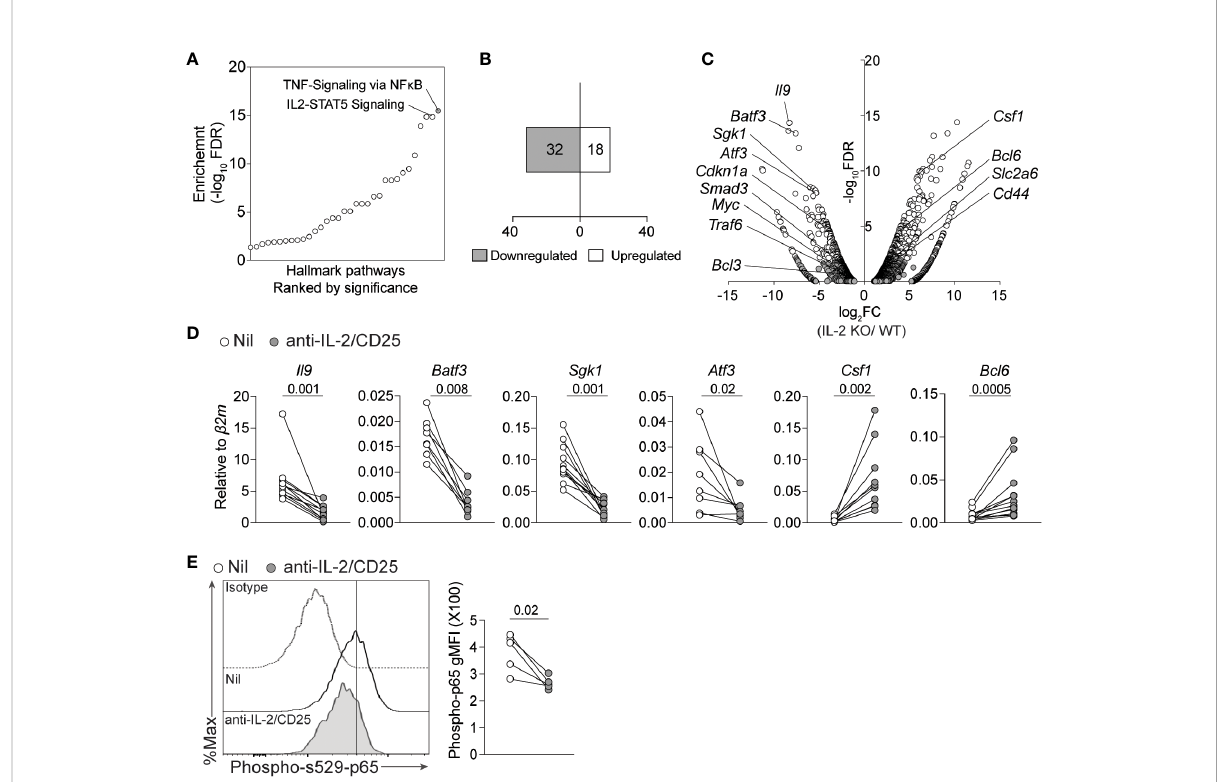
FIGURE 1 IL-2 de fi ciency results in a reduced NF-kB-associated gene signature in Th9 cells. (A) Pathway analysis from bulk-RNA-seq analysis of Th9 cells polarized from WT or IL-2-KO mice previously published ( GSE41317). (B) Number of up- and down- regulated NF-kB signature genes (Fold change >2, p-value<0.05). (C) Volcano plot depicting selected genes regulated by NF-kB that are differentially expressed in IL-2 KO vs WT Th9 cells. (D) Th9 cells were cultured in standard or IL-2-limiting conditions, and 4 days after initial activation total RNA was isolated for qPCR validation of selected NF-kB-associated genes obtained from panel (A) Data in panel (D) are representative of naive T cell cultures from 8-11 individual mice pooled from 3 individual experiments. (E) . Representative histograms and quanti fi ed geometric Mean Fluorescence Intensity (gMFI) of phospho- s529-p65 staining in cells cultured as in (D) Each data point represents values obtained from T cells isolated from one mouse, for a total of n=5 mice. Data were considered signi fi cantly different when paired t -test p value was ≤